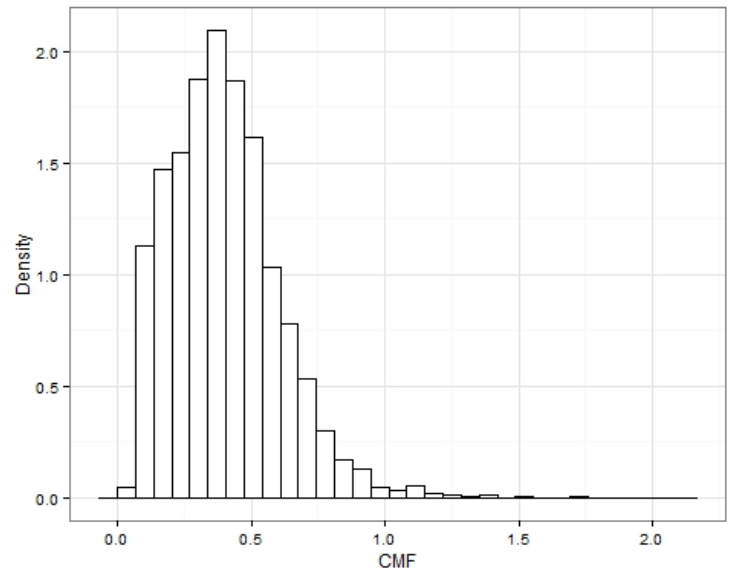
Figure 15. Histogram of the constant motion factor for the